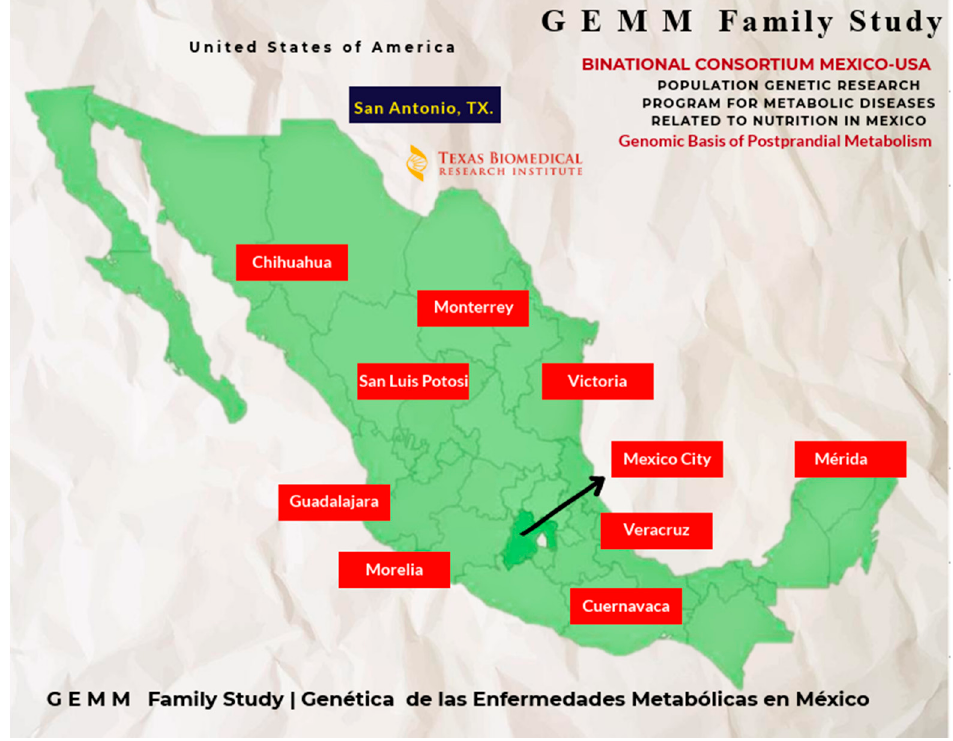
Figure 1. Map of Mexico showing location of GEMM (Genetics of Metabolic Diseases in Mexico) Centers.